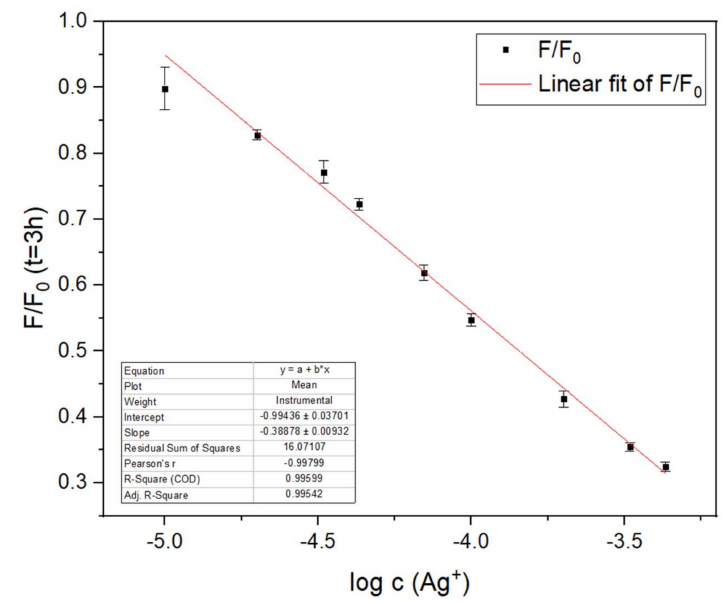
Figure 9. Calibration plot of RhB-EDA in the presence of various Ag + ions concentrations (0.43 × 10 − 3 , 0.33 × 10 − 3 , 0.2 × 10 − 3 , 10 − 4 , 0.7 × 10 − 4 , 0.43 × 10 − 4 , 0.33 × 10 − 4 , 0.2 × 10 − 4 , 10 − 5 , 0.7 × 10 − 5 , 10 − 6 M) in MOPS buffer at pH 7 ( λ ex / λ em = 500/538